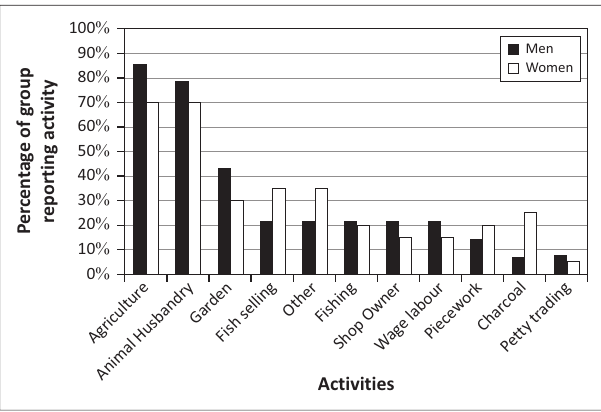
FIGURE 20: Livelihoods activities by gender in Group